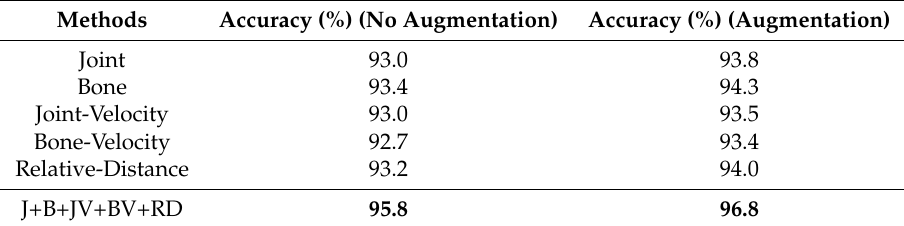
Table 2. Comparisons of the validation accuracy with different input modalities on a cross-view benchmark of the NTU-RGBD dataset.